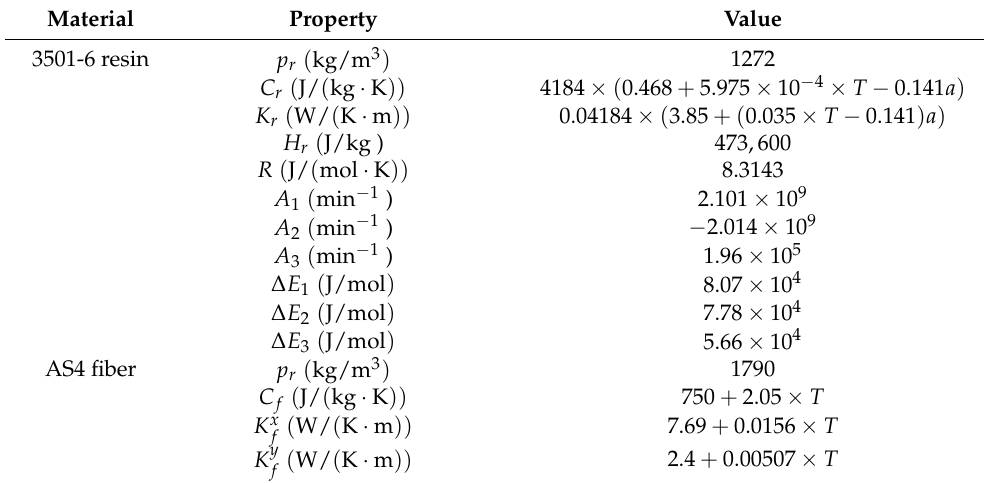
Table 2. Parameters values for the cure kinetics, specific heat capacity and thermal conductivities of resin